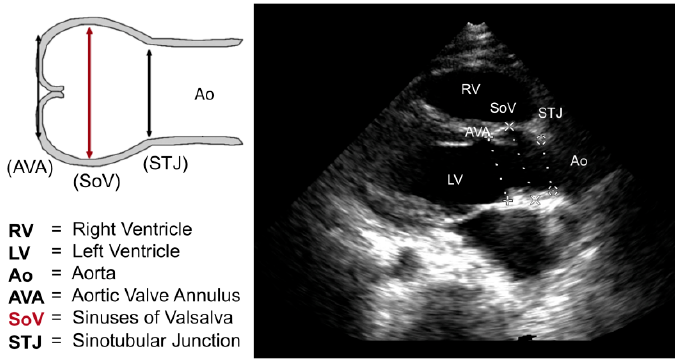
Figure 2. Z Aortic root measurements via schematic and echocardiography at the parasternal long-axis view.